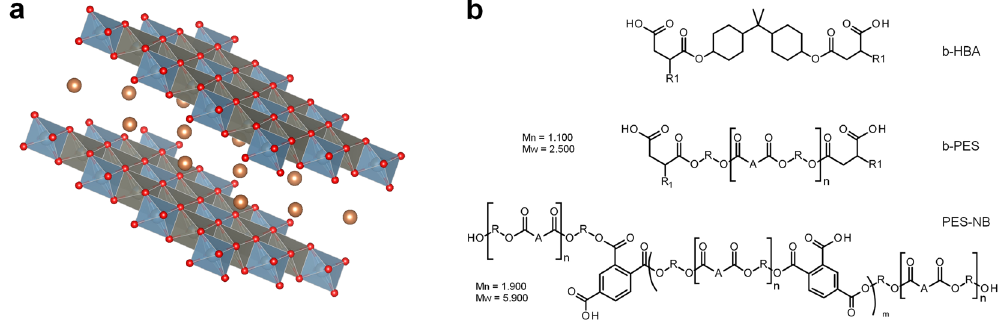
Figure 1. ( a ) Sketch of LDH platelets with intercalated sherical anions (hydrogens are omitted for clarity). ( b ) Formulae of bola-amphiphiles b-HBA and b-PES with octenyl groups “R1” as well as non-bola type polyester PES-NB (cf. methods). For b-PES, “R1” is hydrogenated bisphenol-A (HBA), “A” is an equimolar mixture of dimer fatty and hydrogenated phthalic